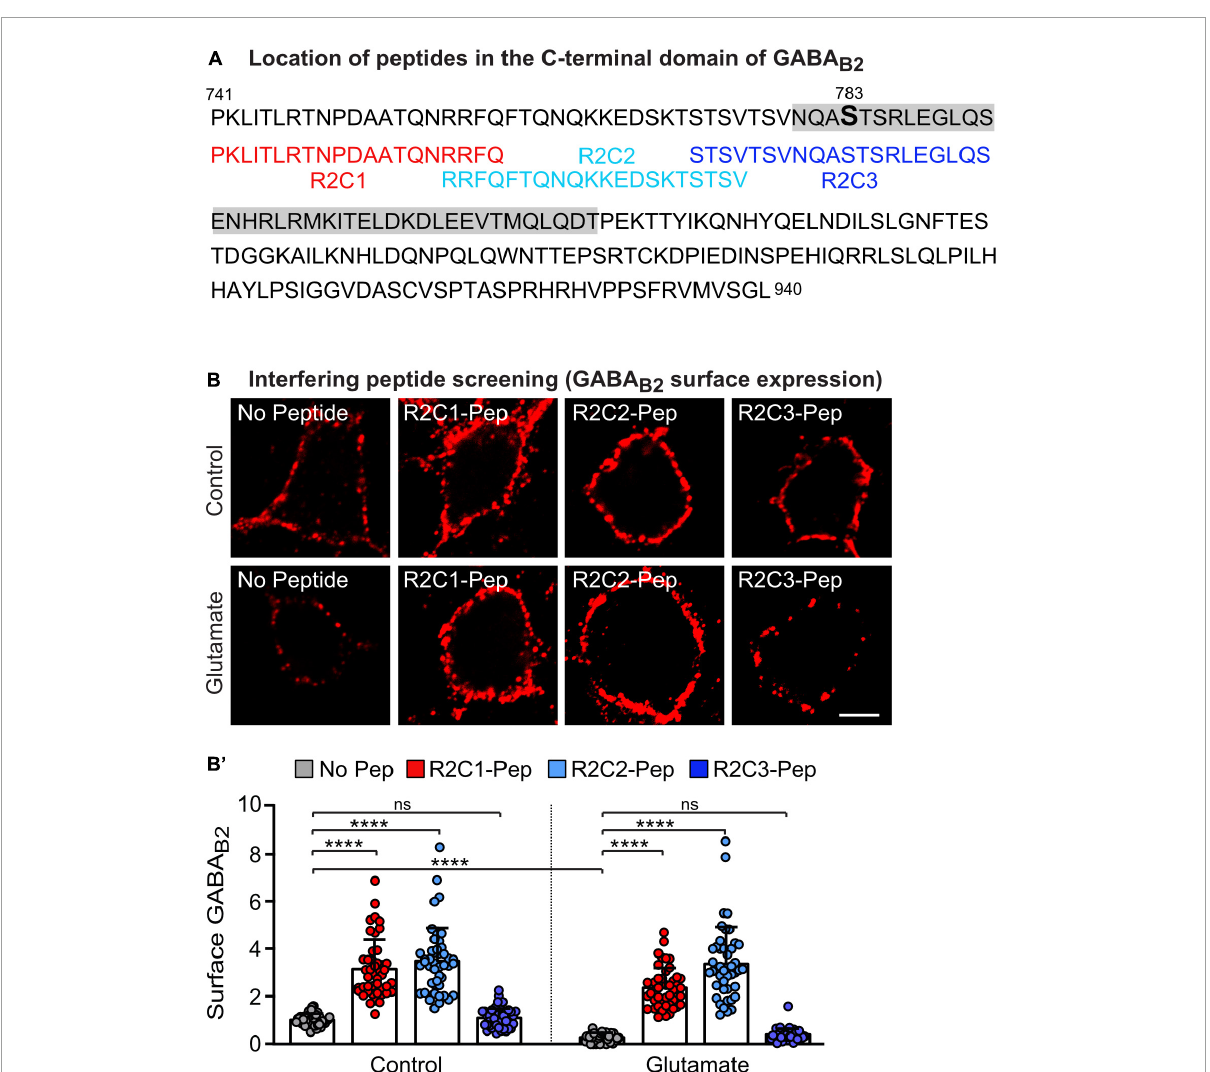
FIGURE2 Screening for a peptide sequence present in the C-terminal domain of GABA B2 that blocks glutamate-induced downregulation of GABA B receptors. (A) Sequence of the C-terminal domain of GABA B2 with the coiled-coil domain indicated in gray and the overlapping peptides R2C1, R2C2 and R2C3 used in (B) shown below. (B,B’) Peptides R2C1 and R2C2 increased expression of GABA B receptors and restored glutamate-induced downregulated receptor cell surface levels. Cultures were stressed for 60 min with glutamate (50 µ M) and immediately thereafter treated for 16 h with the peptides indicated in (A) . Neurons were then tested for cell surface expression of endogenous GABA B receptors using antibodies directed against the N-terminus of GABA B2 . (B) Representative images of GABA B2 cell surface staining (scale bar: 5 µ m). (B’) Quantification of the fluorescence intensities. The data were normalized to cultures not treated with glutamate and peptides and represent the mean ± SD of 45 neurons derived from three independent experiments. Two-way ANOVA followed by Tukey’s